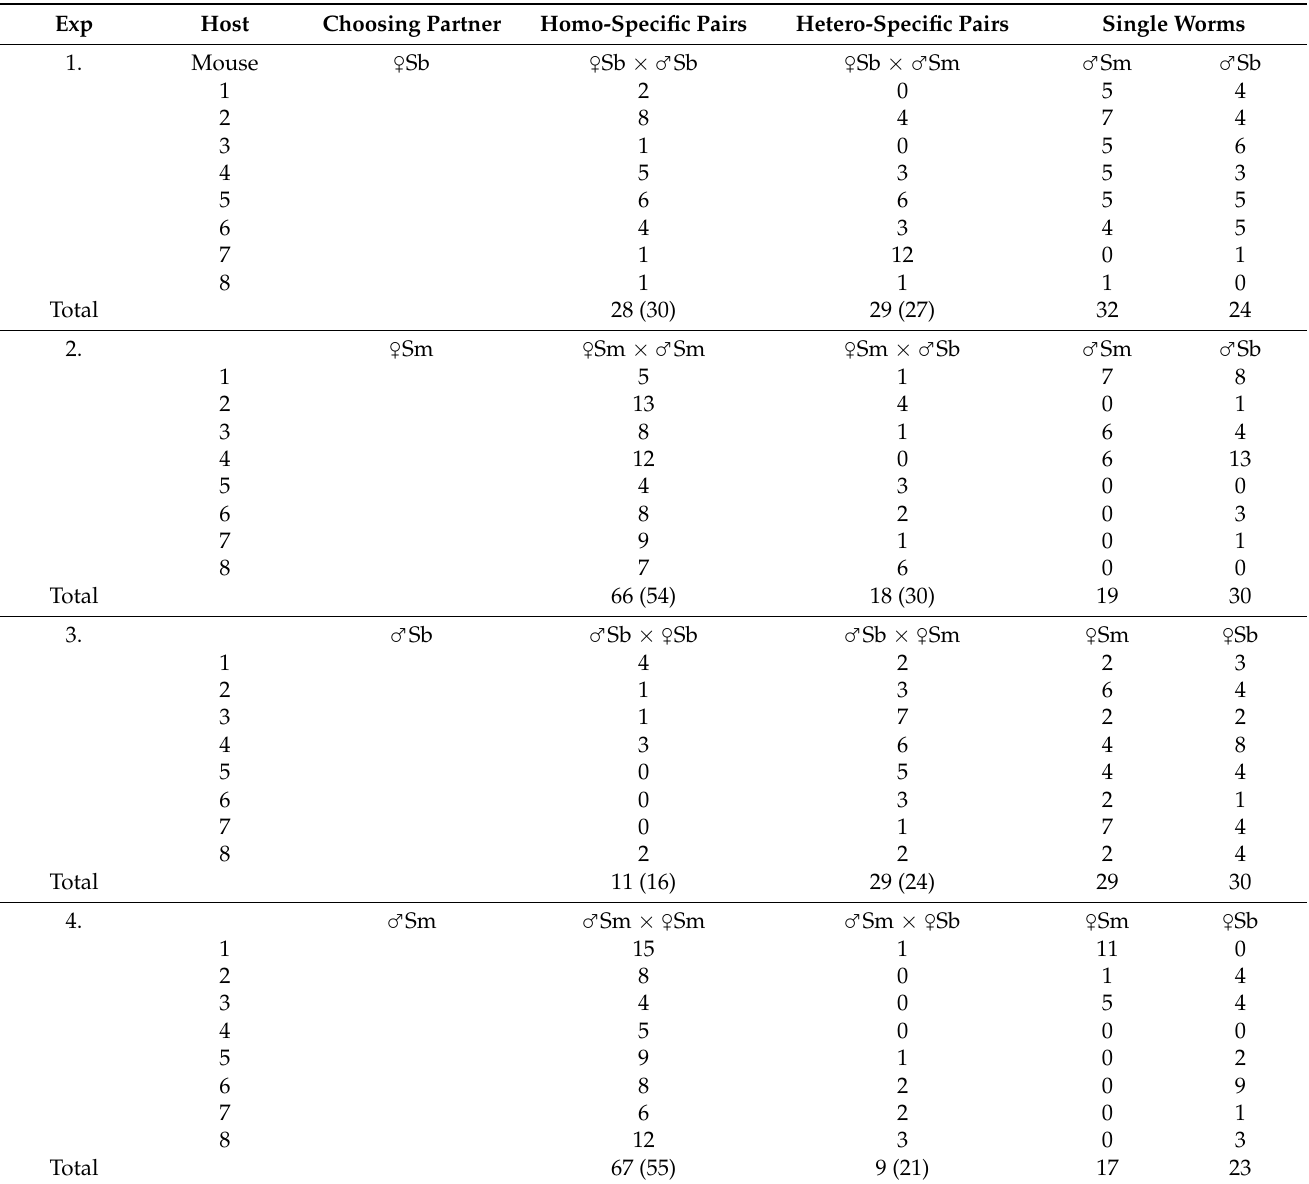
Table 3. Summarized information (limited choice experiments: exp. 1–4), to show numbers of paired (homo- and hetero-specific) and unpaired worms recovered from mice exposed to a limited combination of cercariae. Expected numbers of pairs under random mating is shown in brackets.